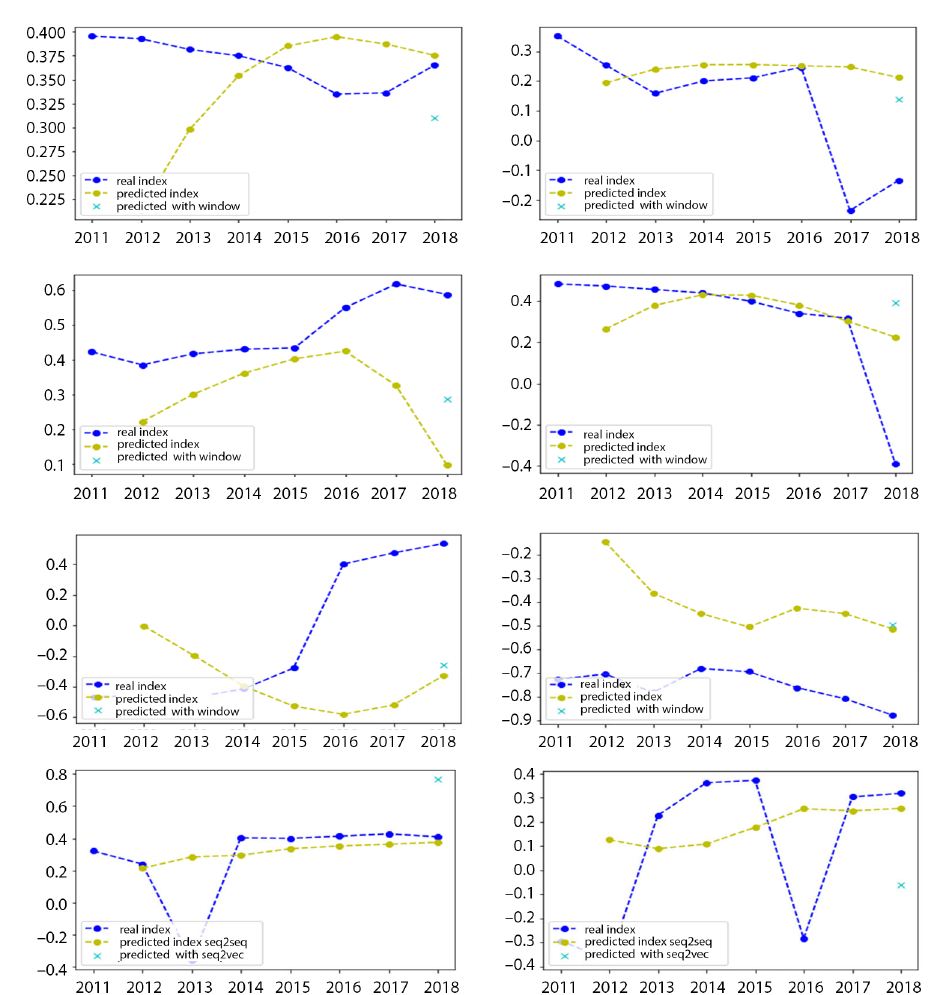
Figure 9. Examples of financial performance index predictions (models E5 and E4) on data not included in the training